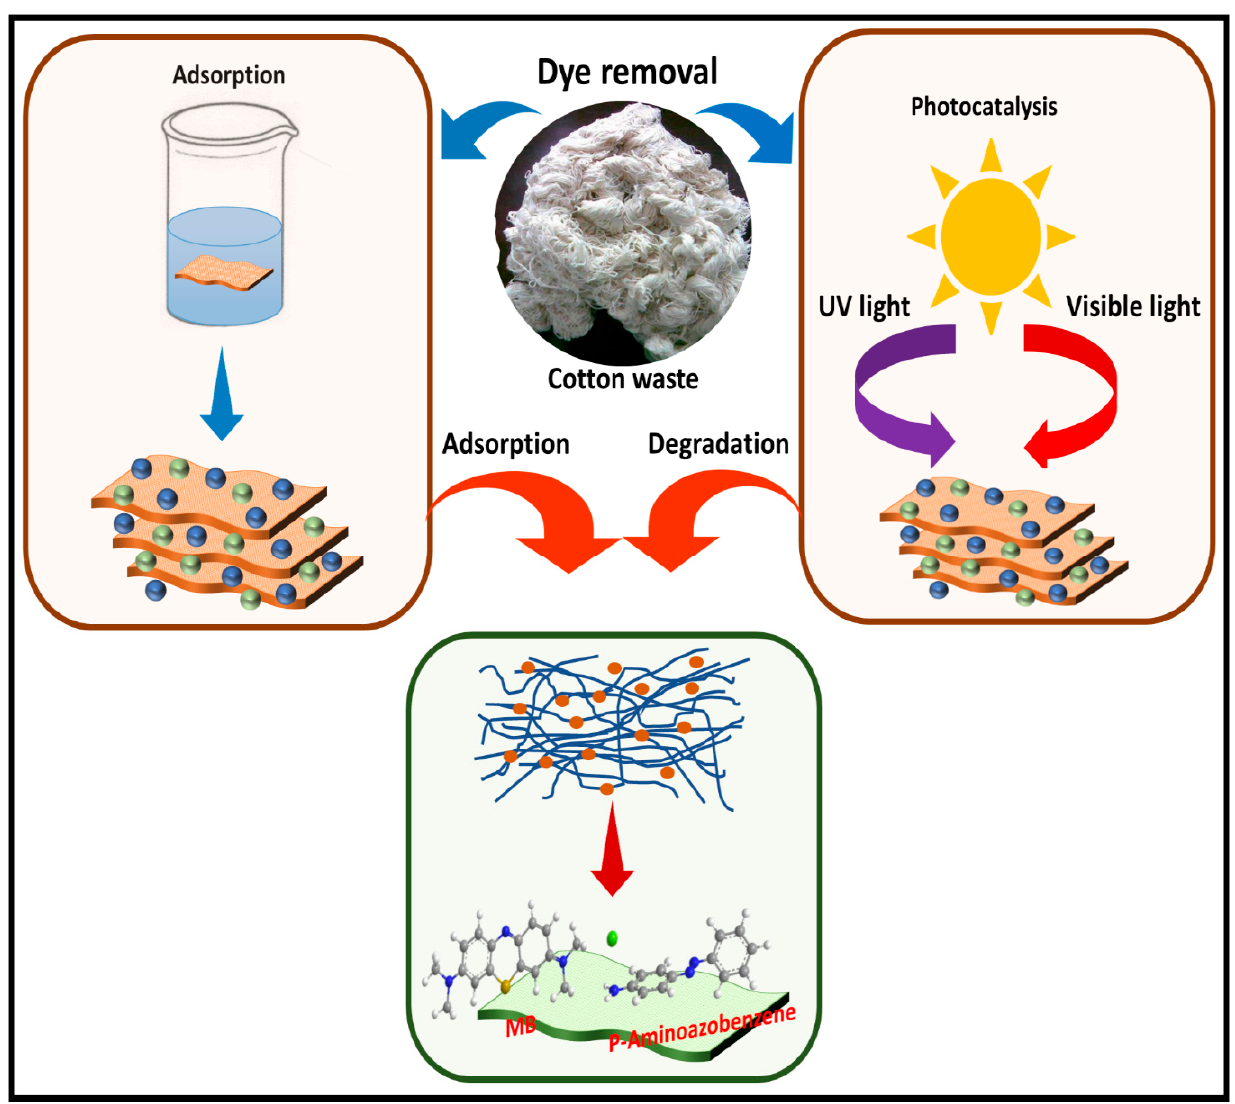
Figure 2. Adsorption and photocatalysis of dye removal using a waste cotton cloth fibre composite.